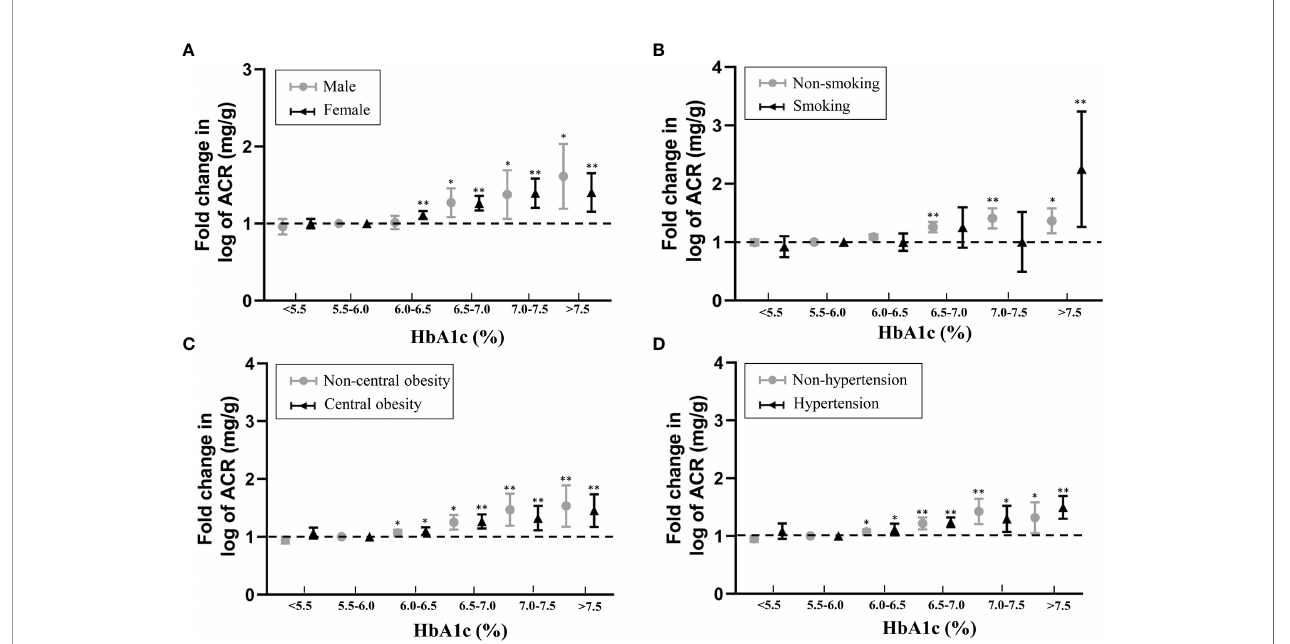
FIGURE 2 | Associations between HbA1c and fold-change in log-ACR in subgroup analyses taking into account with (A) gender, (B) smoking habits, (C) obesity and (D) hypertension. Fold change is relative to 5.5% ≤ HbA1c<6.0% referent category. *P < 0.05, **P <